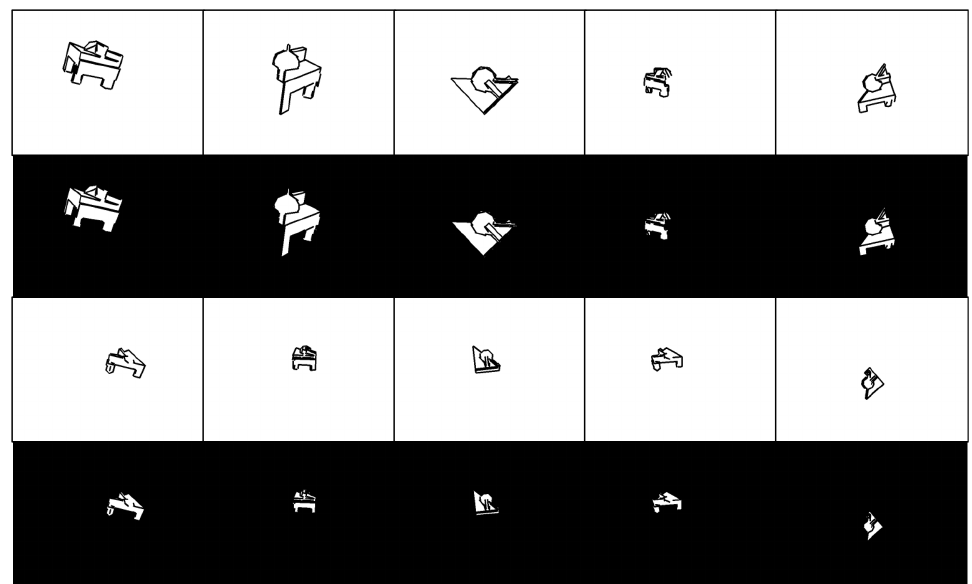
Figure 5. Examples of edge images created by physical environment. These images are width